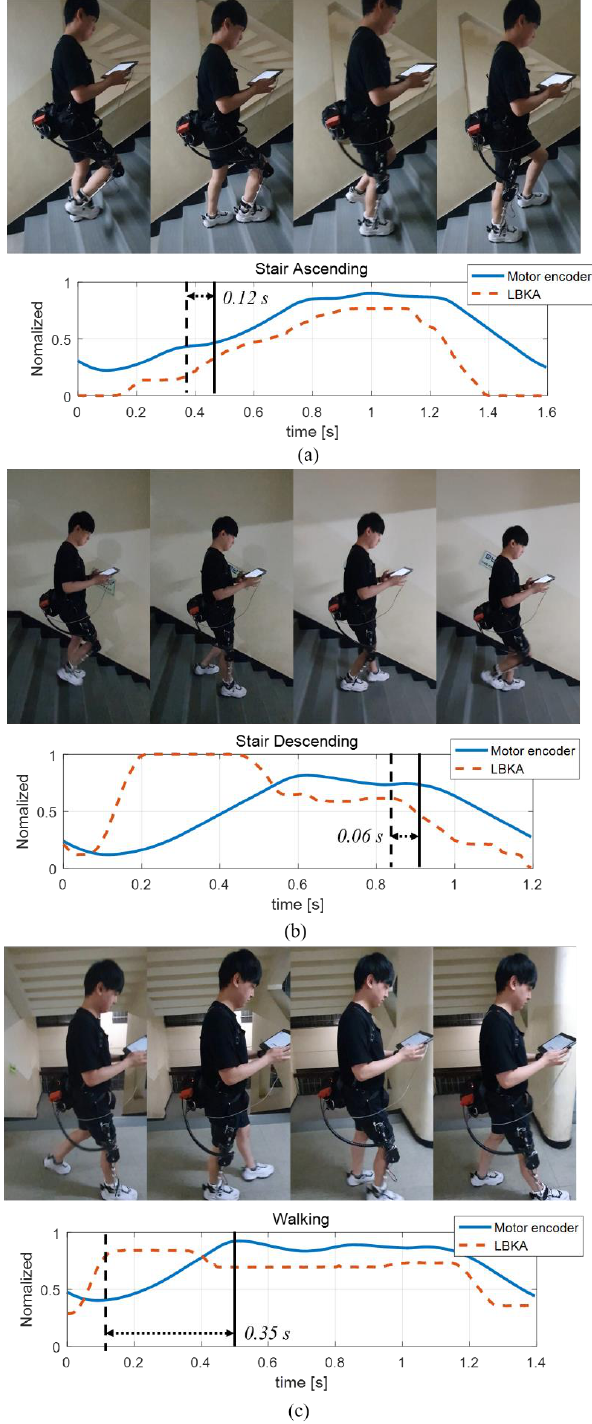
Figure 12. Measured data graph. ( a ) Stair ascending sensor data. The phase difference is 0.12 sec. ( b ) Stair descending sensor data. The phase difference is 0.06 sec. ( c ) Walking sensor data. The phase difference is 0.35 sec.